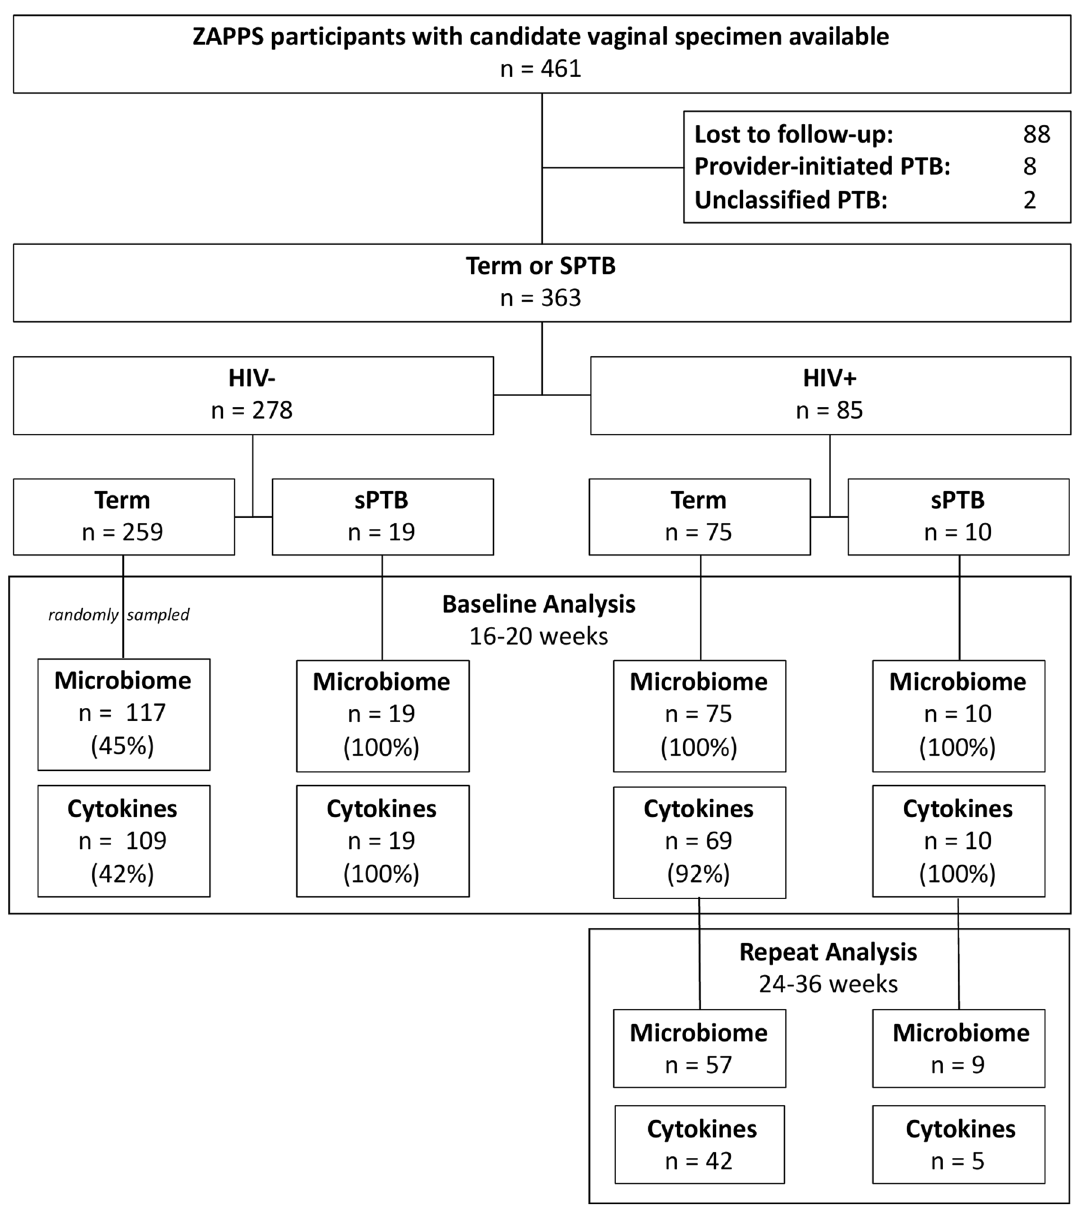
Figure 1. Flowchart of ZAPPS participants with term or spontaneous preterm birth (sPTB) included in vaginal microbiome and cytokine analyses at baseline (16–20 gestational weeks) and repeat (24–36 gestational weeks)